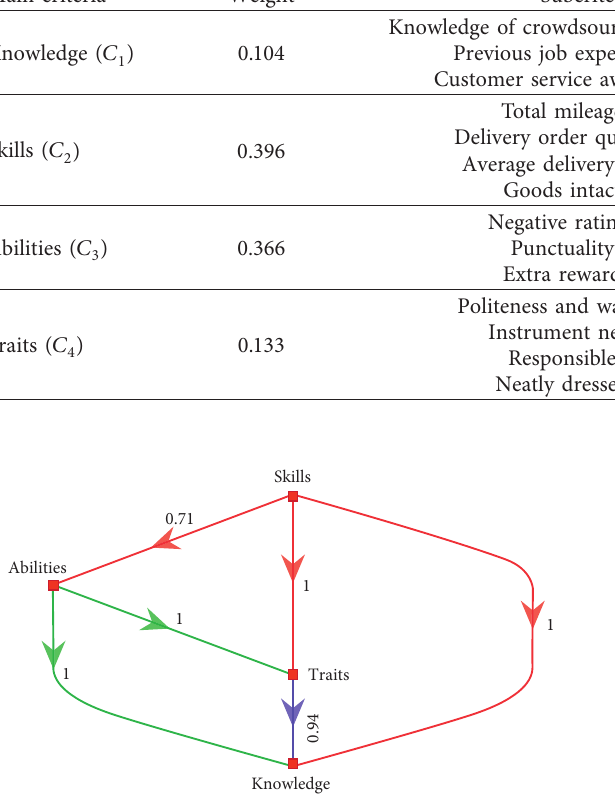
Figure 3: Credal ranking for the main